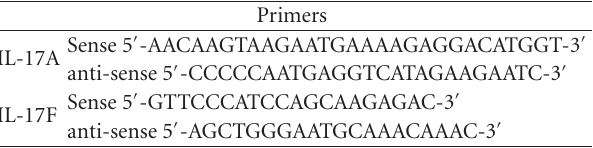
Table 1: Primer sequences for each